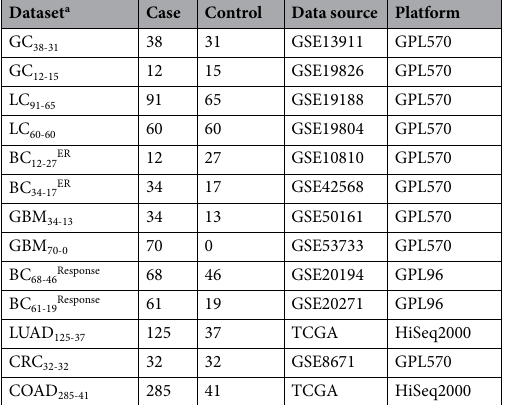
Table 1. Datasets used in this study. Denotes: a GC denotes gastric cancer, LC denotes lung cancer, BC denotes breast cancer, ER denotes estrogen receptor, GBM denotes glioblastoma, LUAD denotes lung adenocarcinoma, CRC denotes colorectal cancer, and COAD denotes colon adenocarcinoma. We referred to each dataset